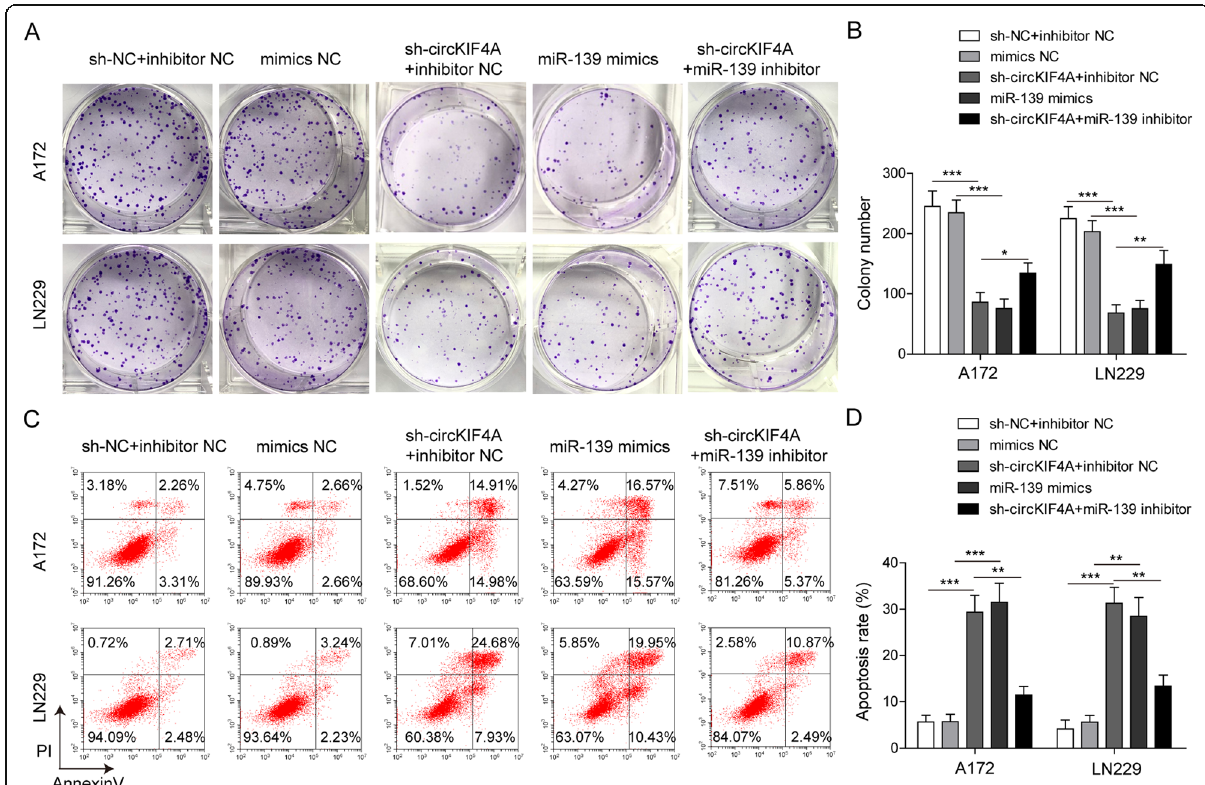
Fig. 3 circKIF4A knockdown inhibited proliferation and promoted apoptosis via miR-139-3p in A172 and LN229 cells. After transfecting cells with sh-circKIF4A, miR-139-3p mimics or miR-139-3p inhibitors, a A colony formation assay to detect A172 and LN229 cells colony-forming ability. b The colony formation number was quantified by Image J. c The A172 and LN229 cells apoptotic rate was determined by flow cytometry. d Quantitative analysis of cell apoptotic rate. * p < 0.05, ** p < 0.01, *** p <